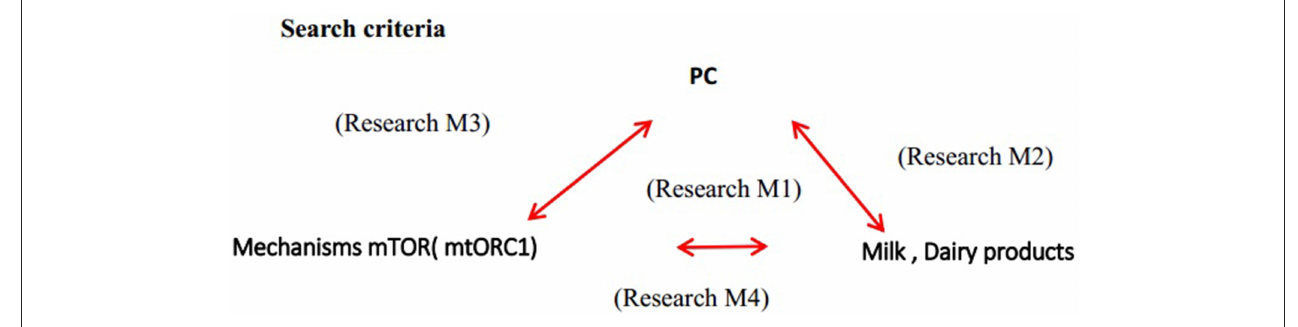
FIGURE 1 | Relationship between various